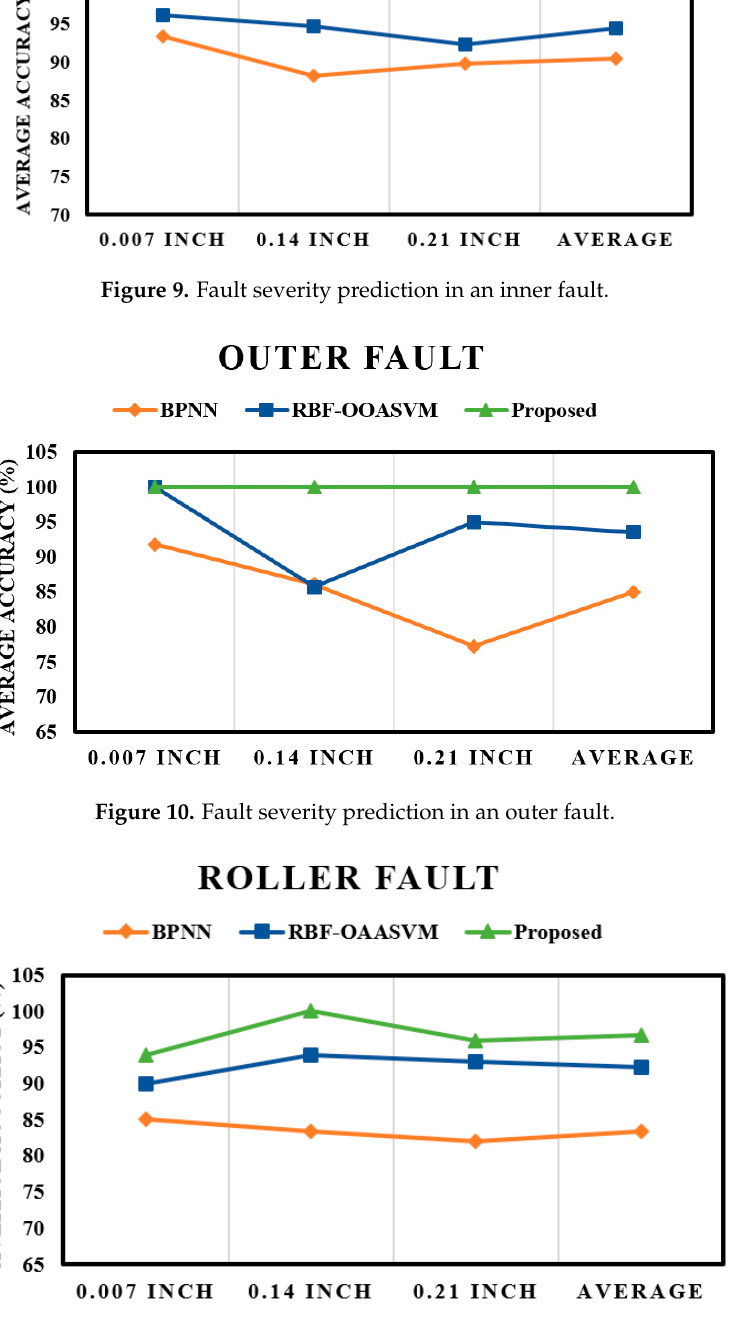
Figure 11. Fault severity prediction in a roller fault.